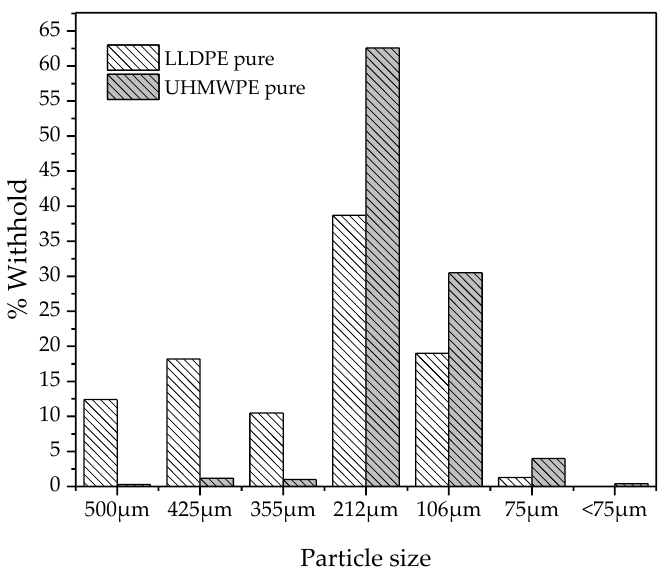
Figure 1. Particle size distribution of LLDPE and UHMWPE.